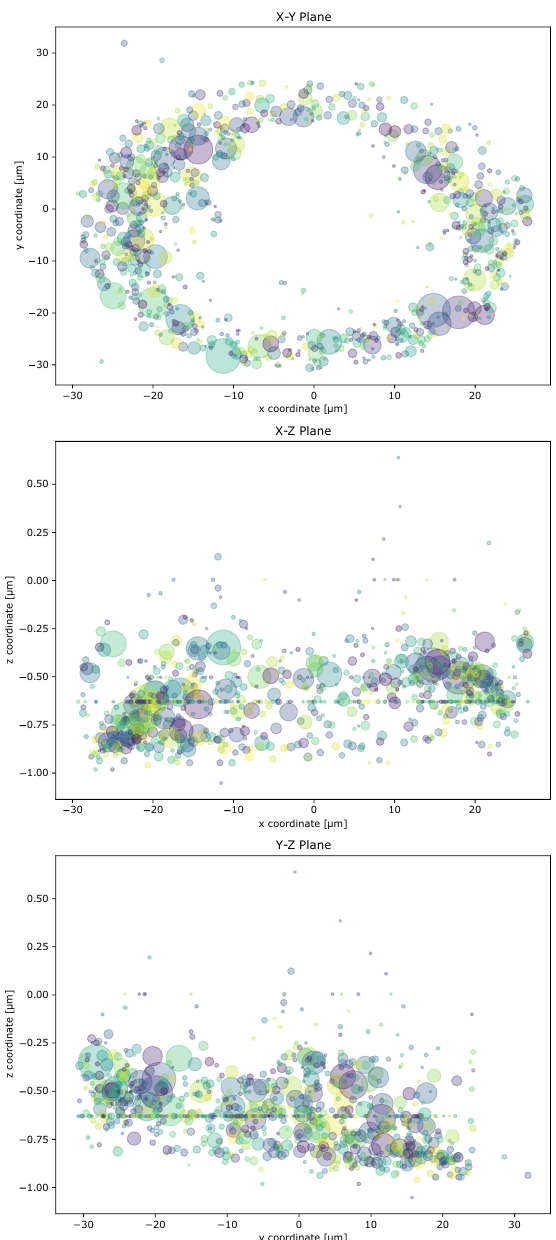
Figure A4. Visualization of the BMPRIb of an example control cell grown on a circular micropattern. Three projections of the receptor accumulation coordinates and virtual masses in the x-y, x-z, and y-z planes. Virtual masses are indicated by the size of the dots. Different dot colors were chosen to differ between overlapping dots. These plots can be automatically generated by ComRed for checkup of found accumulations and their respective weight in the final center of